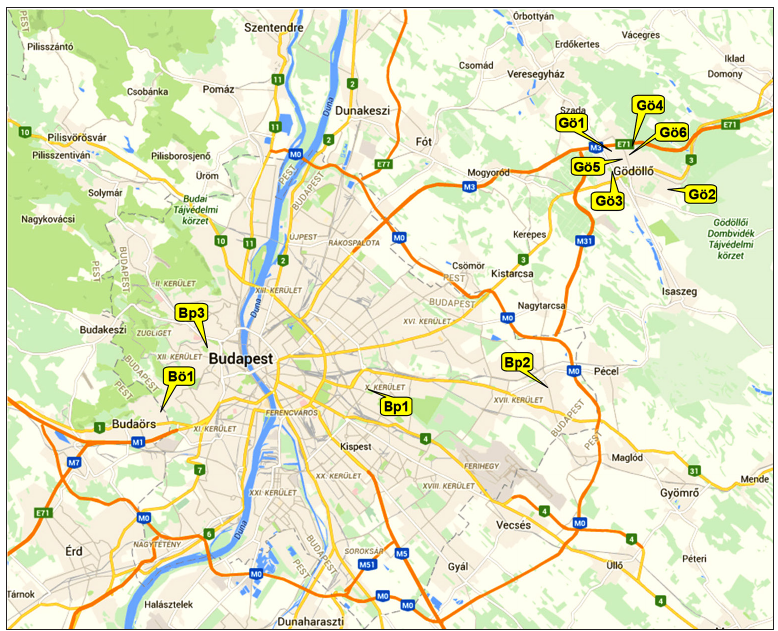
Figure 1. The locations of the homes in Pest county and